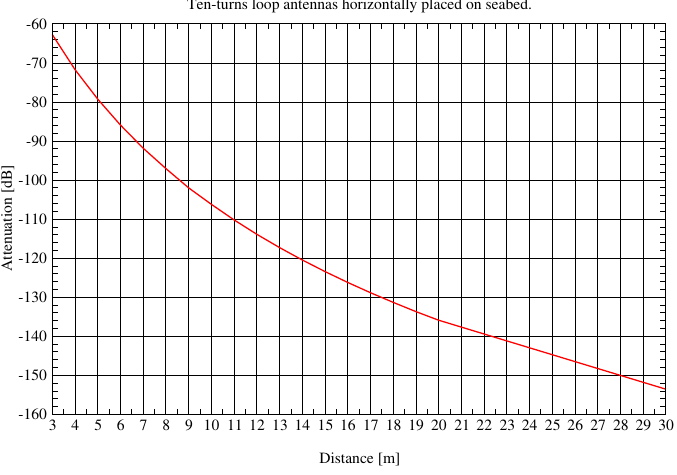
Figure 14. Optimum frequency for a given